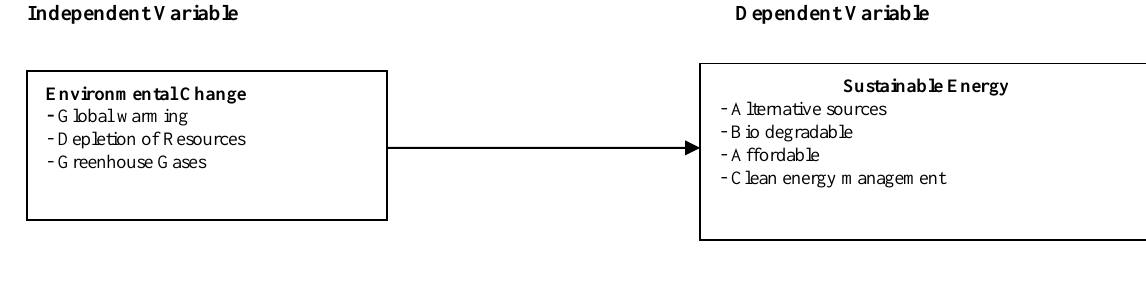
Figure 1: Conceptual